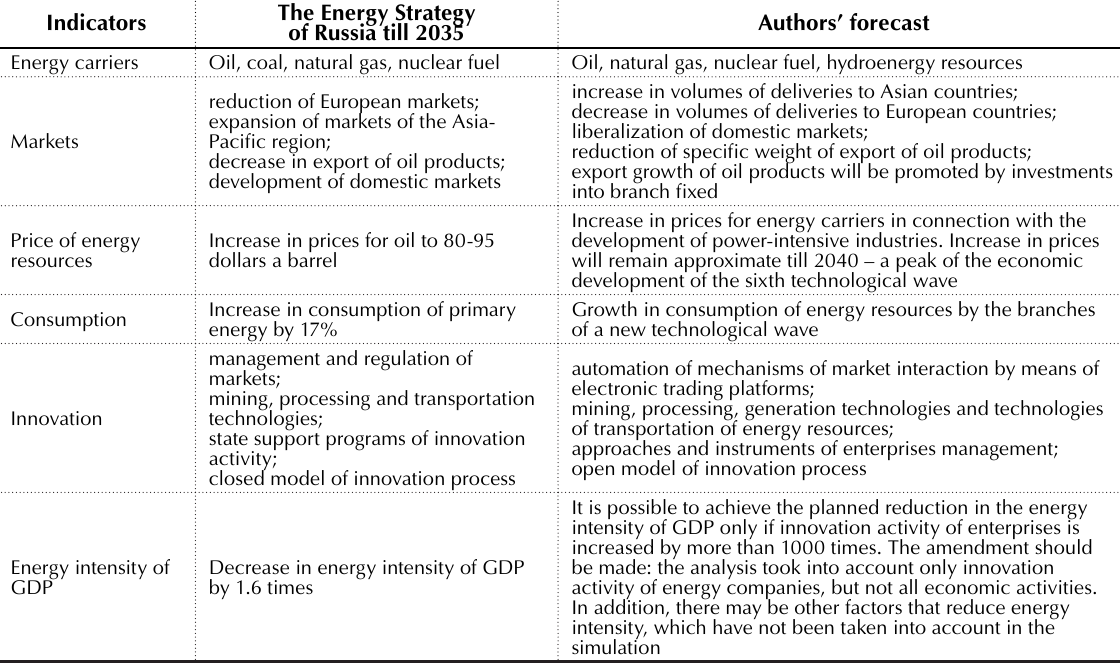
Table 3. Key directions for the development of the fuel and energy complex of Russia Source: Key World Energy Statistics (2016), The Global Innovation Index